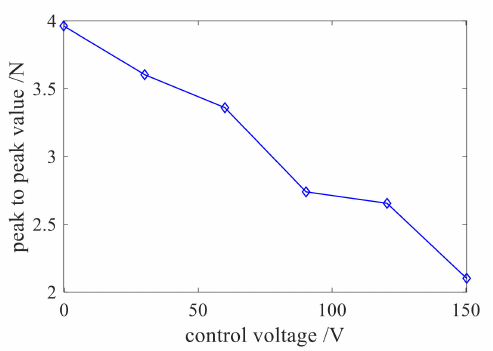
Figure 14. Relationship between peak and peak value of shaft system over-critical vibration response and control voltage.